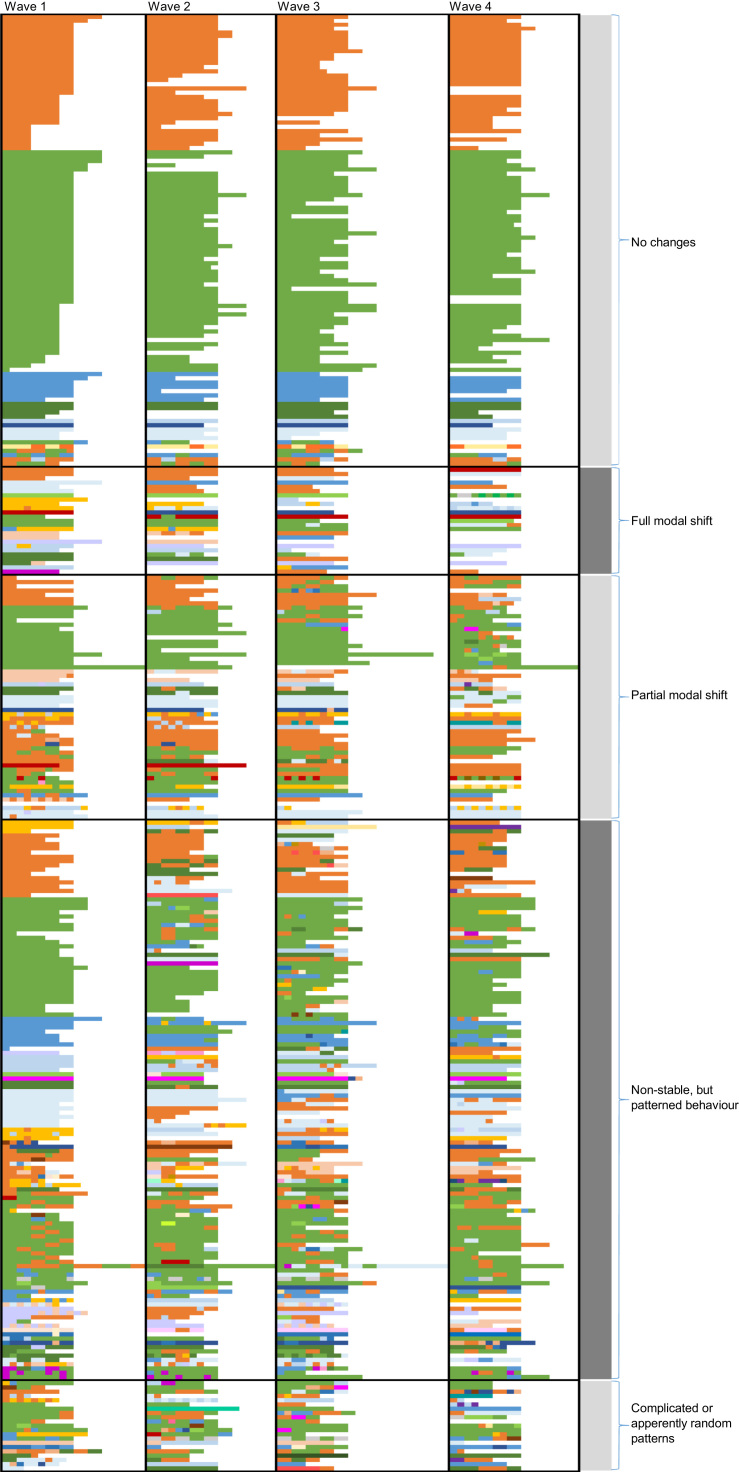
Overview of all mode choices over the four waves. Each horizontal line represents an individual. The waves are separated by vertical black lines. Each trip is one square, individually colour-coded and the length of the line corresponds with the number of commute trips made over one week. Each colour represents one modal combination. Orange = car only; green = bicycle only; blue = walk only; yellow = train only; and brown = bus only. The white colour indicates no trip was made. Full legend: see Appendix D. (For interpretation of the references to color in this figure legend, the reader is referred to the web version of this article.)